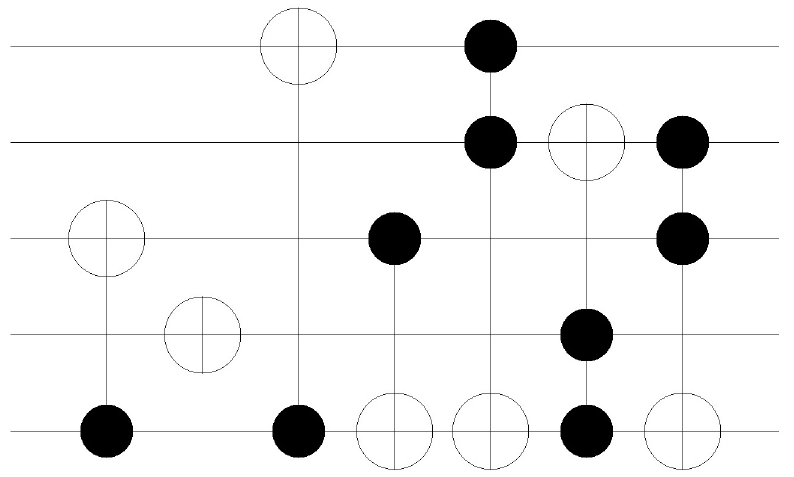
Fig 17. Resulting circuits of No. 18 4gt4_v1 with varying N